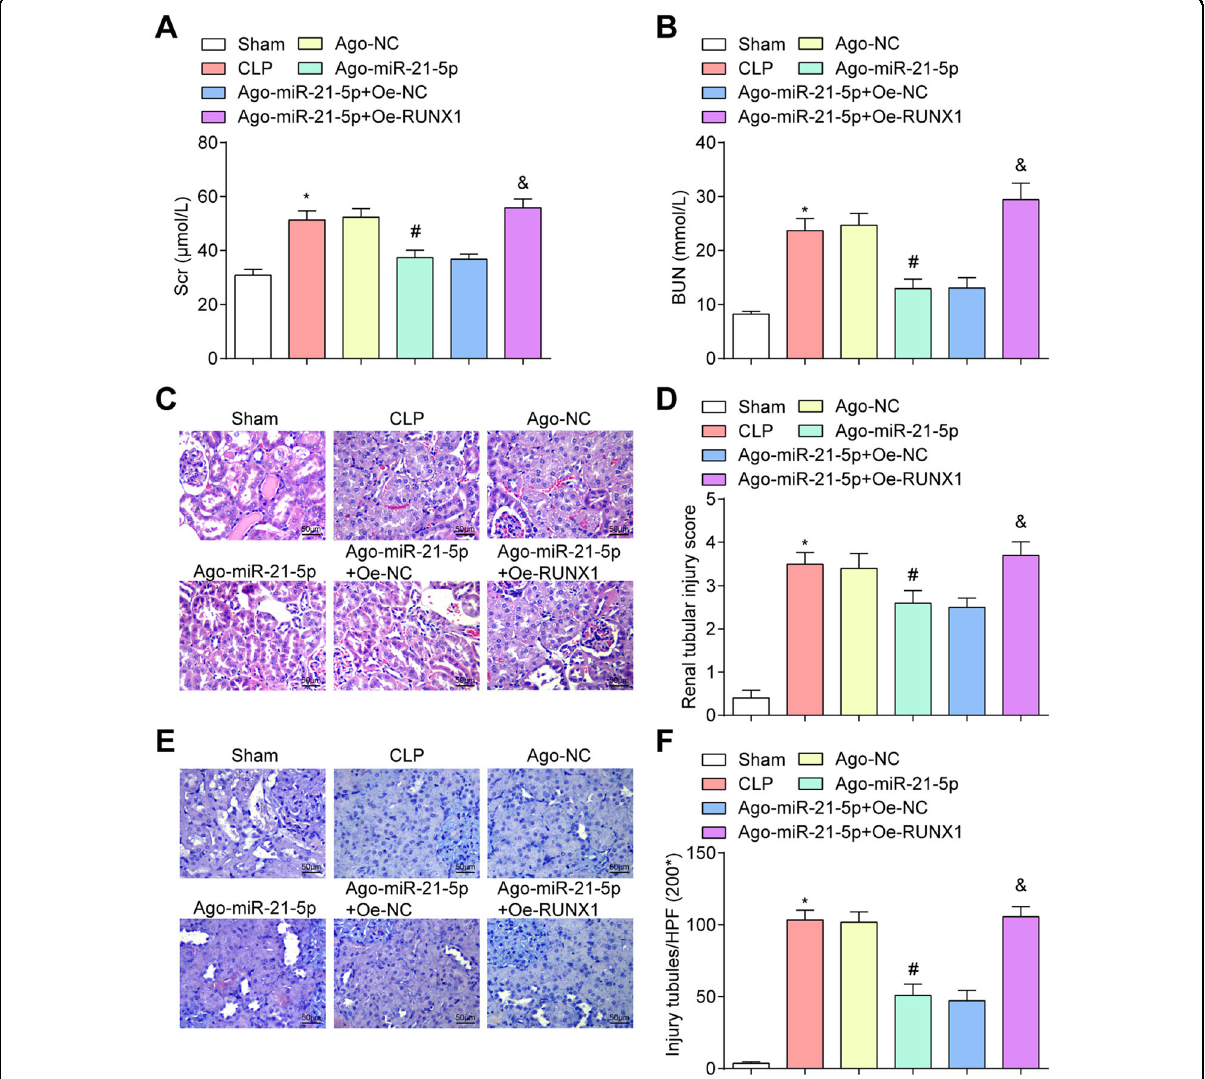
Fig. 1 Effects of upregulation of miR-21-5p on renal function and pathological changes in the kidney of CLP rats. A Comparison of Scr concentration in CLP rats. B Comparison of BUN concentration in CLP rats. C HE staining of rat renal tissues (scale bar = 50 μ m). D Comparison of renal tubular injury scores in CLP rats. E PAS staining of rat renal tissues of CLP rats (scale bar = 50 μ m). F Comparison of the number of renal tubular injuries of CLP rats. n = 10. * P < 0.05 vs. the sham group. # P < 0.05 vs. the Ago-NC group. & P < 0.05 vs. the Ago-miR-21-5p + Oe-NC group. Measurement data were depicted as mean ± standard